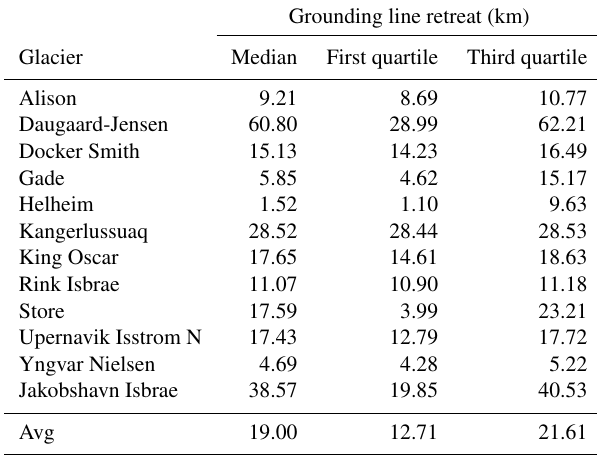
Table 4. Median and first and third quartiles of grounding line re- Table 3. Median and first and third quartiles of SLR contribution treat from each glacier under RCP8.5 scenario (SMB, subglacial from each glacier under RCP8.5 scenario (SMB, subglacial dis- charge and ocean temperature (min and max)). Values are corrected discharge and ocean temperature (min and max)). Values are cor- from drift. rected from SLR ( mm )